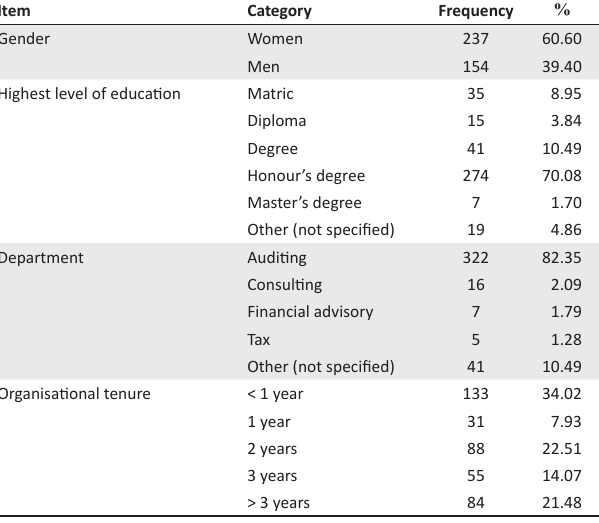
TABLE 1: Demographic and employment characteristics of